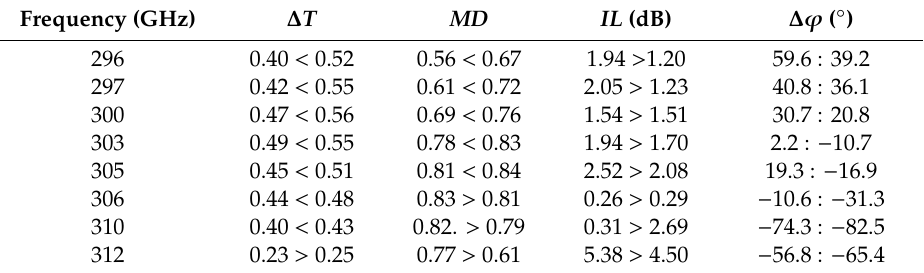
Table 3. Comparison of two LC samples (S200 and S200-2) at certain frequency points. Frequency (GHz)